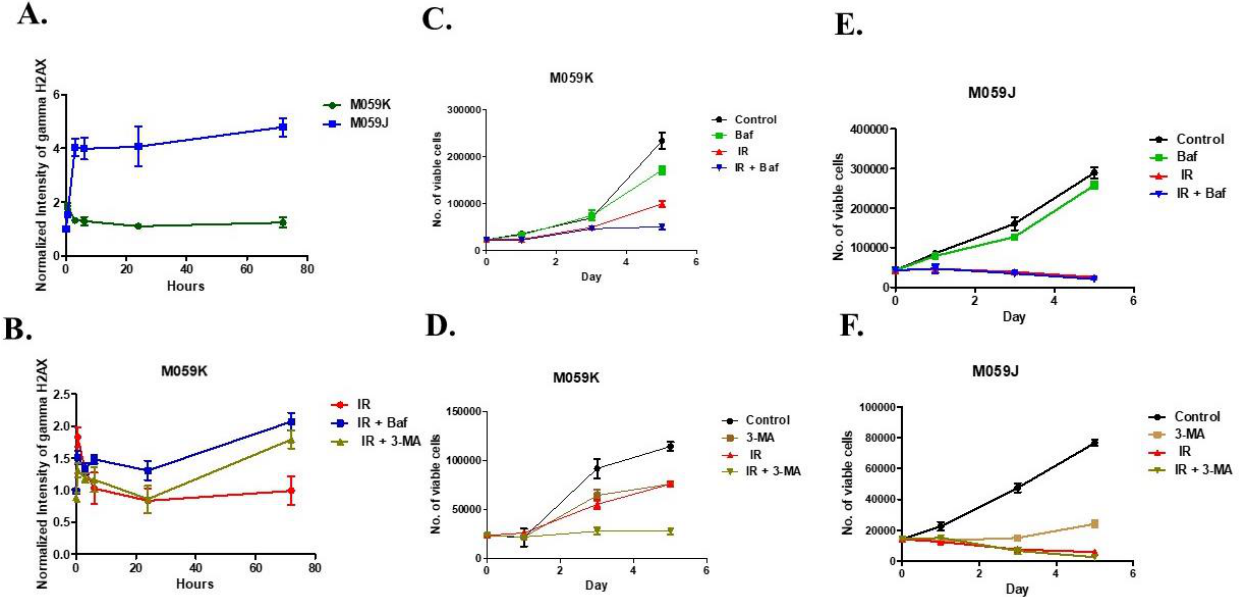
Figure 3. Autophagy inhibitors affect responses to radiation and interrupt DNA repair. ( A ). M059K and M059J cells were exposed to 4 Gy and the extent of γ -H2AX formation was evaluated by performing flow cytometry at 0, 30 min, 3, 6, 24, and 72 h. ( B ). M059K cells were pretreated with Bafilomycin A1 (50 nM) or 3-MA (5 mM) to inhibit autophagy and monitored γ -H2AX formation in irradiated cells at 0, 30 min, 3, 6, 24, and 72 h. ( C ). M059K cells were pretreated with Bafilomycin A1 (50 nM) and irradiated with 4 Gy on day 0 and counted on days 1, 3, and 5. ( D ). M059K cells were pretreated with 3-MA (5 mM) and irradiated with 4 Gy on day 0, and counted on days 1, 3, and 5. ( E ). M059J cells were pretreated with Bafilomycin A1 (50 nM) and irradiated with 4 Gy on day 0, and counted on days 1, 3, and 5. ( F ). M059J cells were pretreated with 3-MA (5 mM) and irradiated with 4 Gy on day 0, and counted on days 1, 3, and 5. Error bars represent standard error. For all these figures “control” indicates vehicle (DMSO) -treated cells that were not exposed to radiation, Baf, or 3-MA.